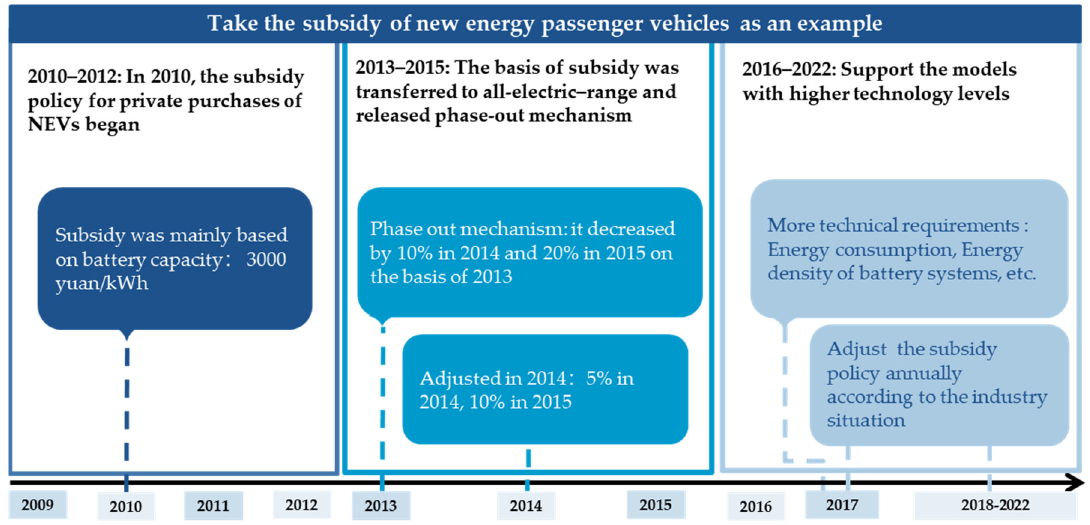
Figure 2. China’s NEVs purchase subsidy policy.